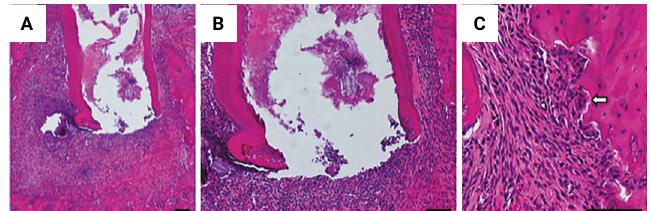
Figure 3. Microphotographs showing HE stained histological sections of the experimental distal root of the mandibular first molar (E1) with pulp necrosis and immature apex (A). Necrotic tissue can be seen inside the root canal; neither odontoblasts lining the dentine surface or HERS can be observed (B). Actively resorbing osteoclasts and Howship lacunae can be seen on the alveolar bone surface (arrow in C). Bars represent